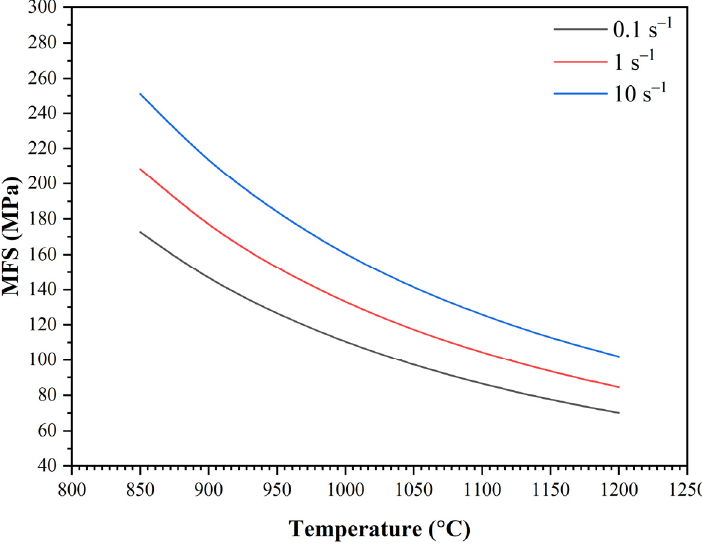
Figure 21. Dependence of MFS on the temperature and strain rate calculated according to Equation (10).